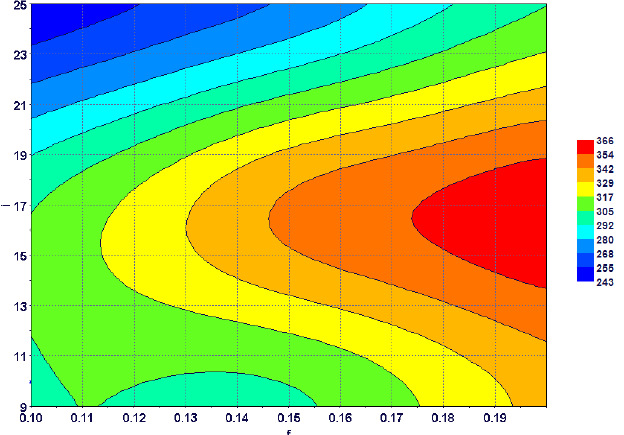
Figure 10. Combined effect of feed rate and inclination angle on maximum tool stress.